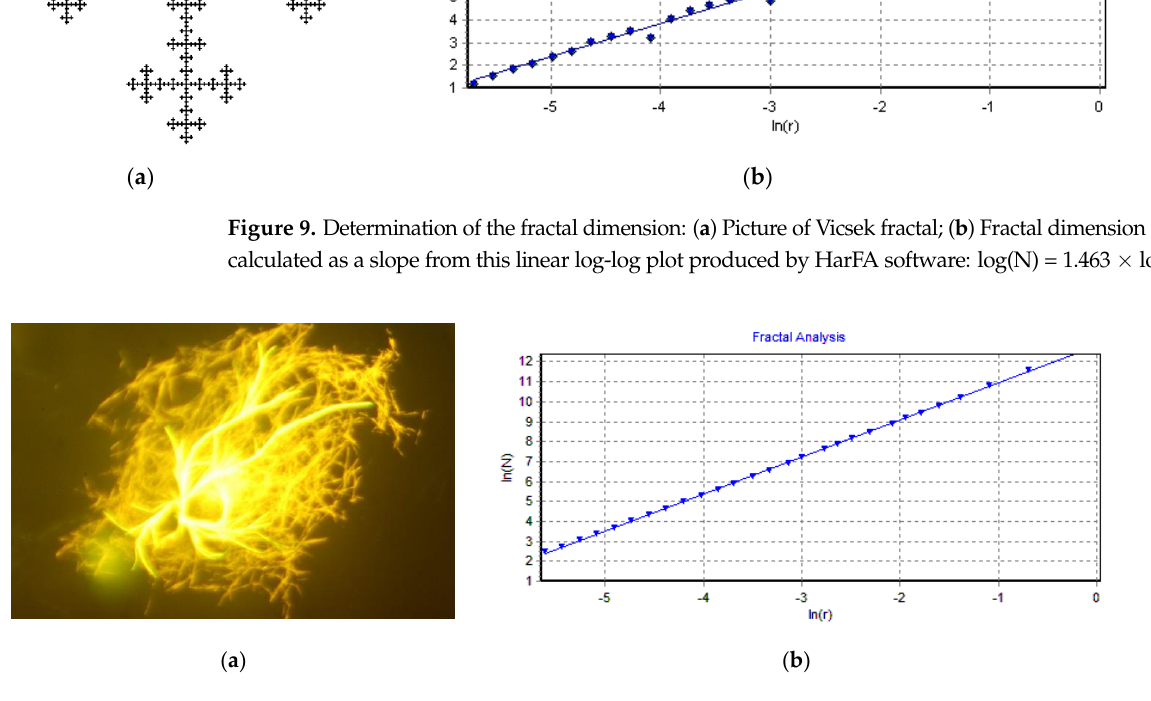
Figure 10. Determination of the fractal dimension: ( a ) Picture of lysozyme amyloid plaque; ( b ) Fractal dimension can be calculated as a slope from this linear log-log plot produced by HarFA software: log(N) = 1.859 × log(r).